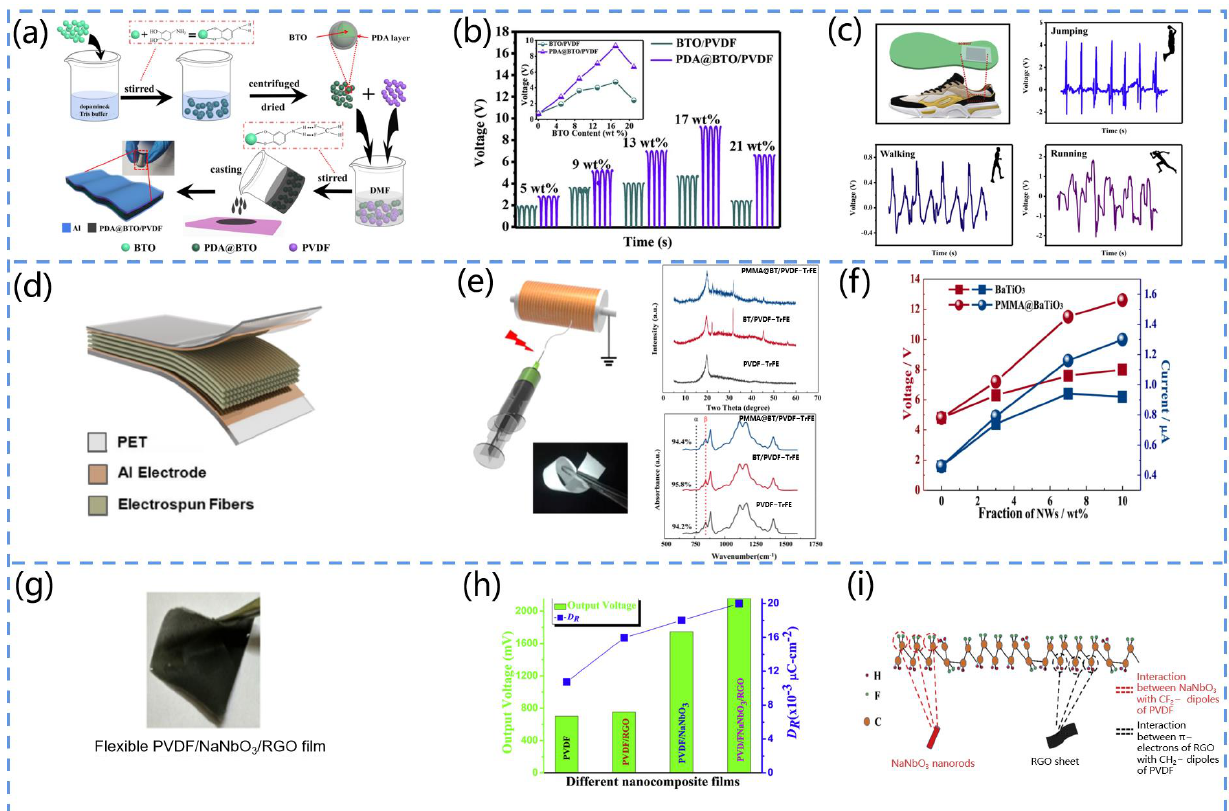
Figure 6. ( a ) Illustration of the preparation process of the PDA@BTO/PVDF composite membrane. ( b ) Output profiles of the BTO/PVDF and PVDF/PDA@BTO-based sensors when the BTO content is varied. ( c ) Voltage response to running, walking, and jumping upon embedding in the insole. Reprinted with permission from [88]. Copyright 2020, Elsevier. ( d ) Schematic diagram of the structure of PENG. ( e ) The process of electrostatic spinning to fabricate composite fibers and their XRD spectra and FT-IR spectra, the α corresponds to the nonpolar α -phase of PVDF-TrFE and the β corresponds to the electroactive β -phase of PVDF-TrFE. ( f ) Output voltages and currents of PENGs with different NWs components. Reprinted with permission from [89]. Copyright 2021, Elsevier. ( g ) Diagram of the structure of the PVDF/NaNbO 3 /RGO composite membrane. ( h ) Output voltage and residual polarization of the PVDF/NaNbO 3 /RGO composite membrane. ( i ) Mechanistic diagram of the interaction of NaNbO 3 and RGO with PVDF (H, F, and C correspond to the hydrogen, fluorine, and carbon elements, respectively). Reprinted with permission from [90]. Copyright 2017,